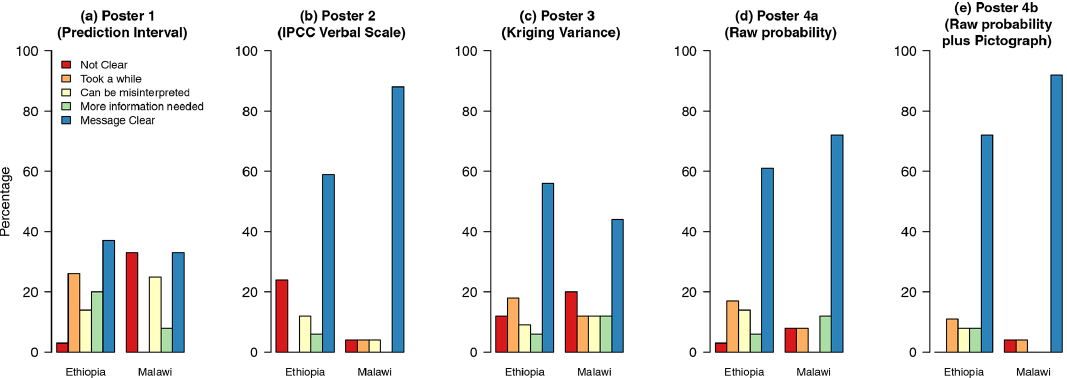
Figure 2. Bar charts showing how participants when pooled within the location of the meeting responded to the interpretive task (Q1).